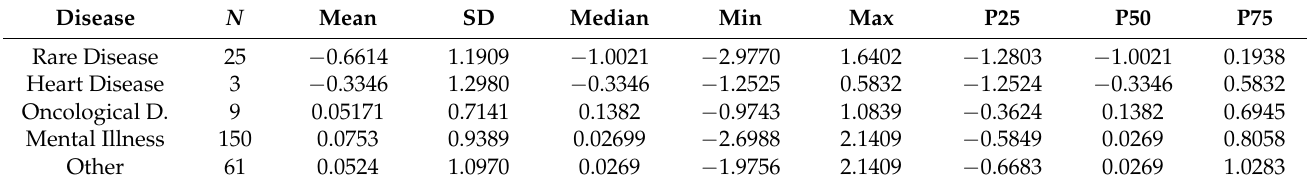
Table 5. Descriptive statistics of the quality-of-life factor according to the disease variable.